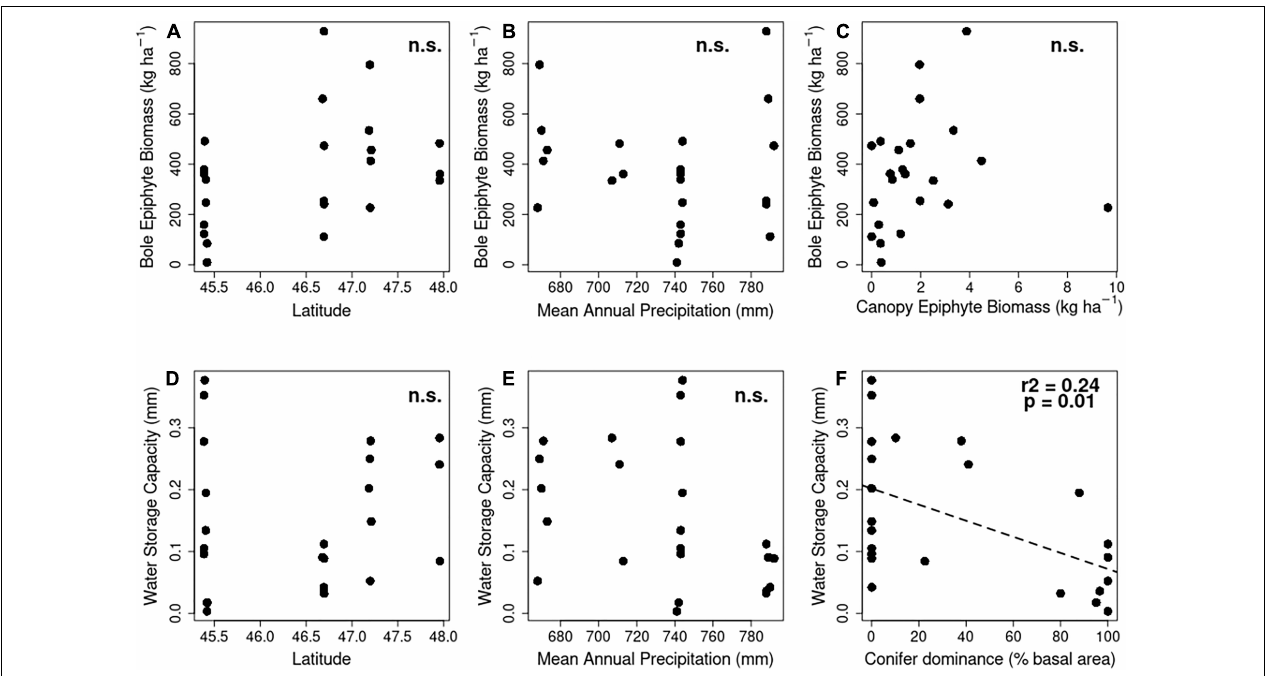
FIGURE 2 | Relationships of bole epiphyte community biomass (A–C) and potential water storage capacity (D–F) to plot and site characteristics, including site latitude (A,C) , mean annual precipitation (B,E) and stand composition (F) . Results of linear regressions are reported in each sub-panel. n.s., not significant at p <